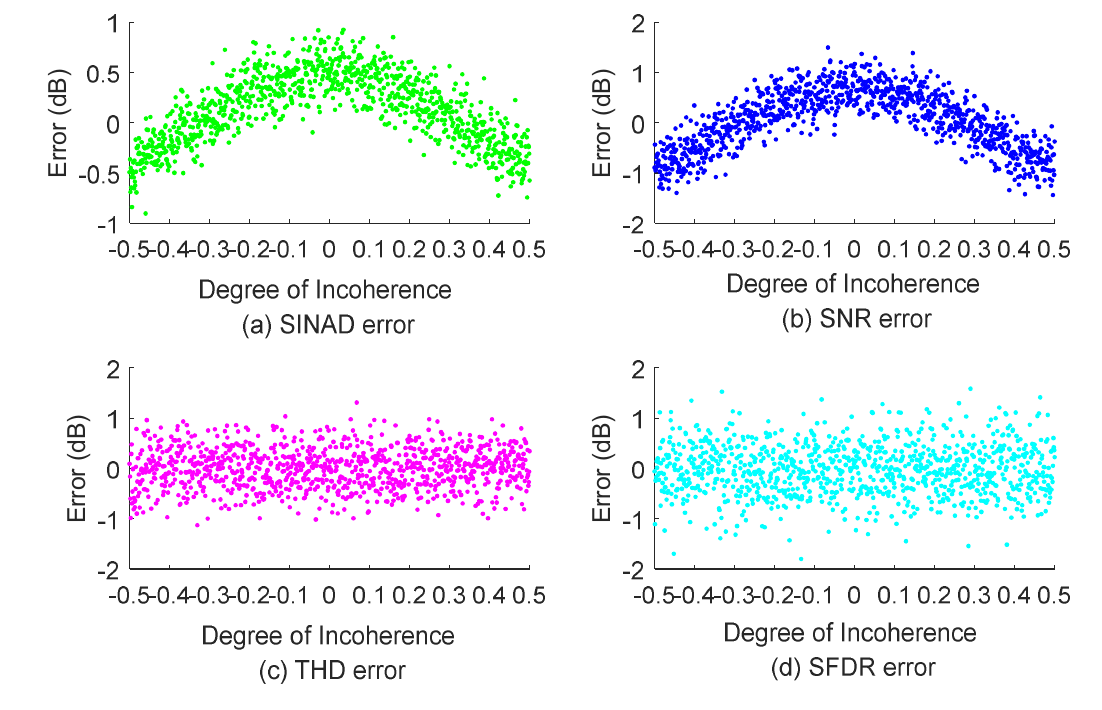
Figure 6. Algorithm robustness verification.